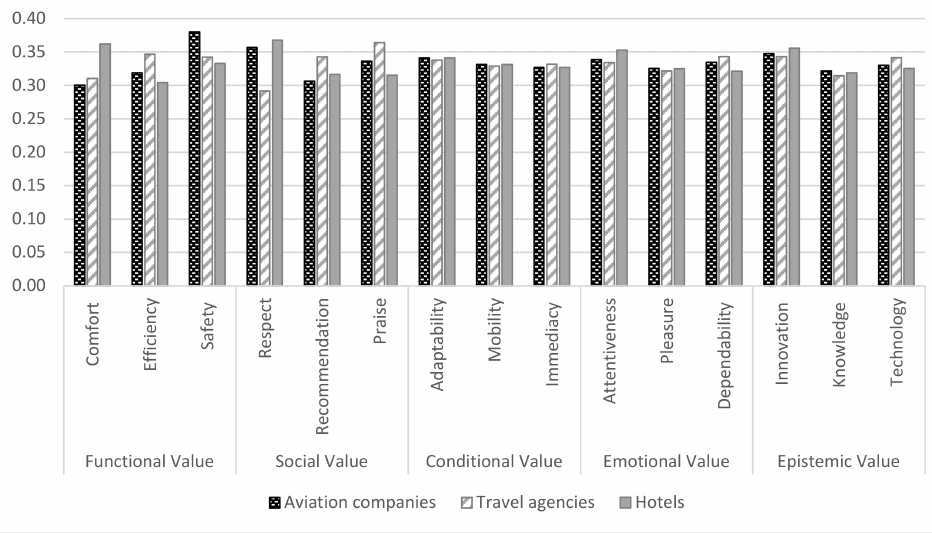
Figure 5. Weights comparison of the service quality attributes in the three